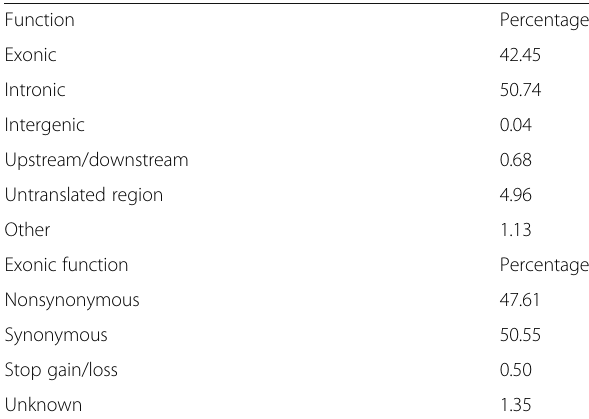
Variant burden analyses Table 2 Functional annotation of the intersect file using